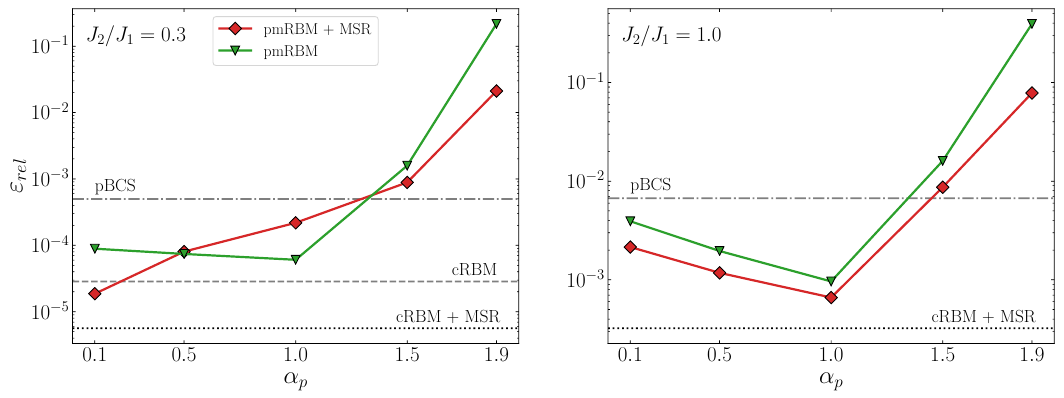
− J Heisenberg model with 1 2 / J = 1 (right panel). The pmRBM 2 1 + α = 2. The results for the , with α p m p = 1, such that the total number of c / J = 1 (right panel), 2 1